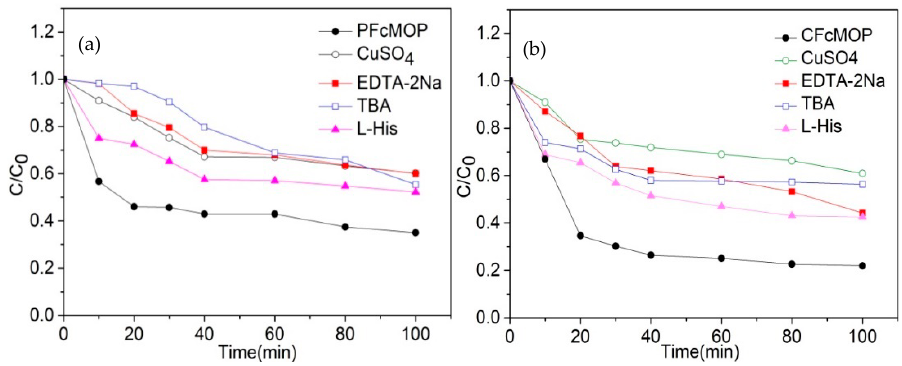
Figure 6. Free radical trapping experiments of PFcMOP ( a ) and CFcMOP ( b ).